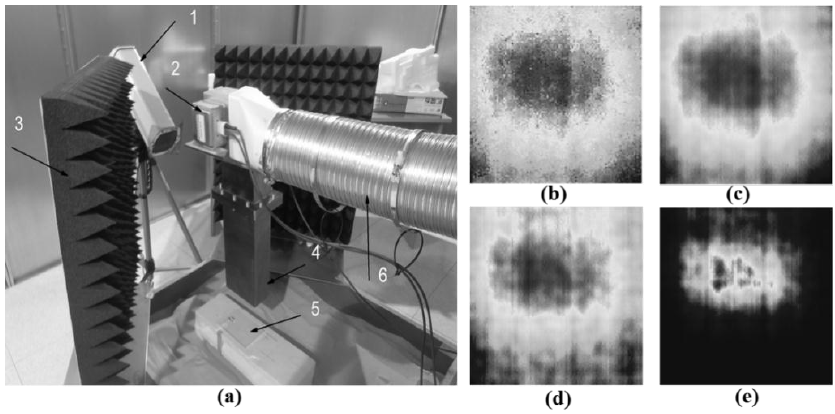
Figure 11. Experimental setup for MWT ( a ) and measurement results ( b – e ) [68]. Reprinted/reproduced with permission from authors.